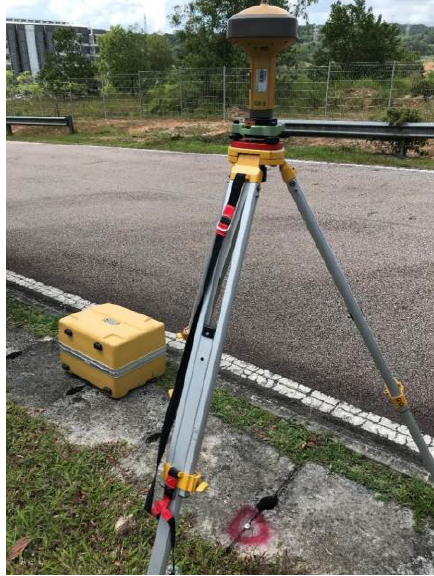
Figure 4. GPS Observation